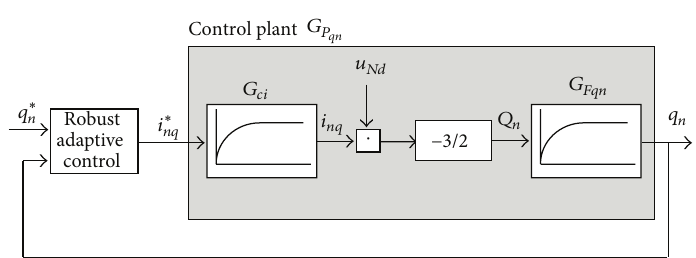
Figure 3: Block diagram of the